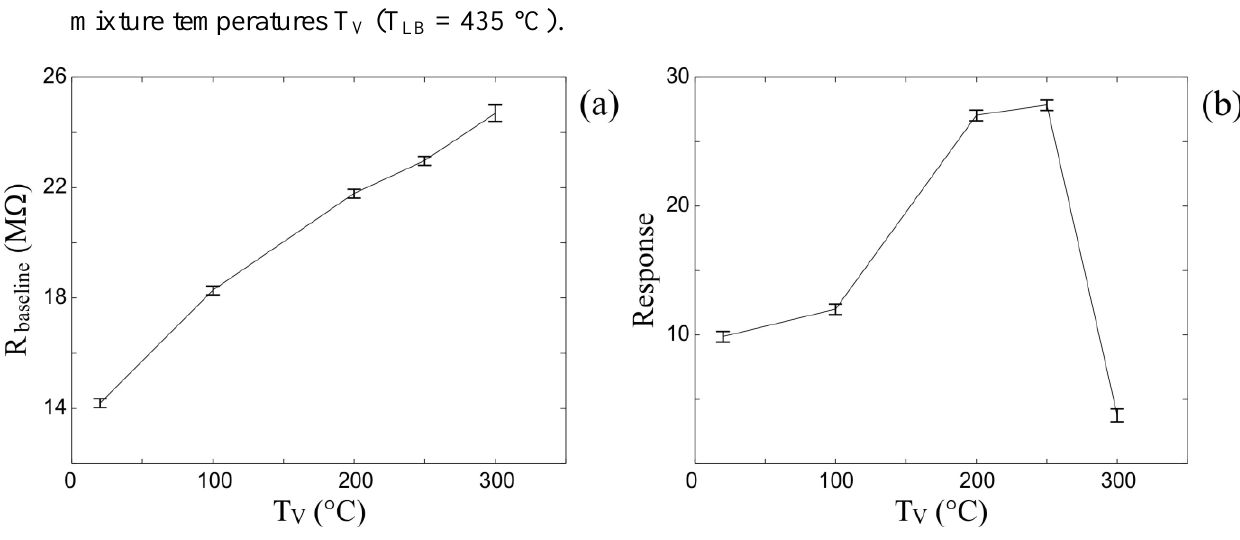
; ( b ) The average V